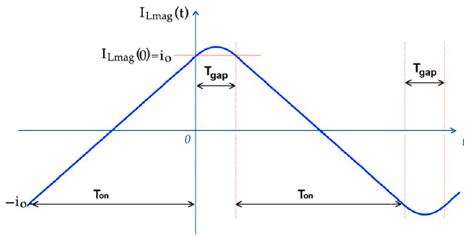
Figure 9. Evolution of i Lmag (t) during a switching period.